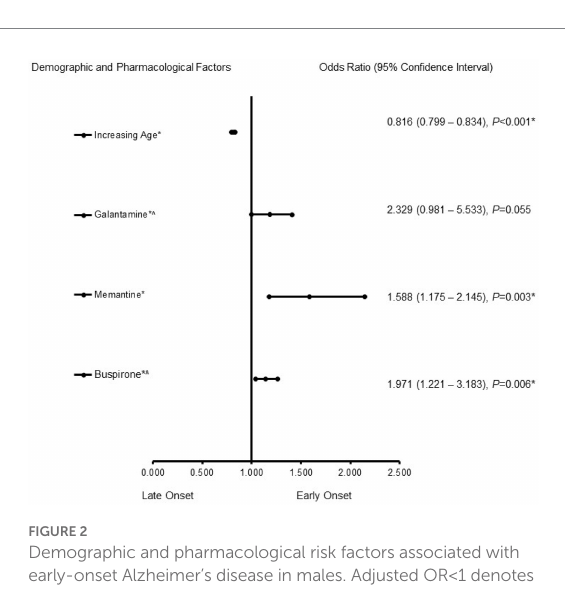
FIGURE 2 Demographic and pharmacological risk factors associated with early-onset Alzheimer’s disease in males. Adjusted OR < 1 denotes factors associated with a -onset, while OR > 1 denotes factors associated with an early onset. Hosmer-Lemeshow test ( p < 0.001*), Cox & Snell ( R 2 = 0.187). The overall classified percentage of 93.3% was applied to check for the fitness of the regression model. The asterisk (*) Indicates statistical significance ( p < 0.05) with a 95% confidence interval.